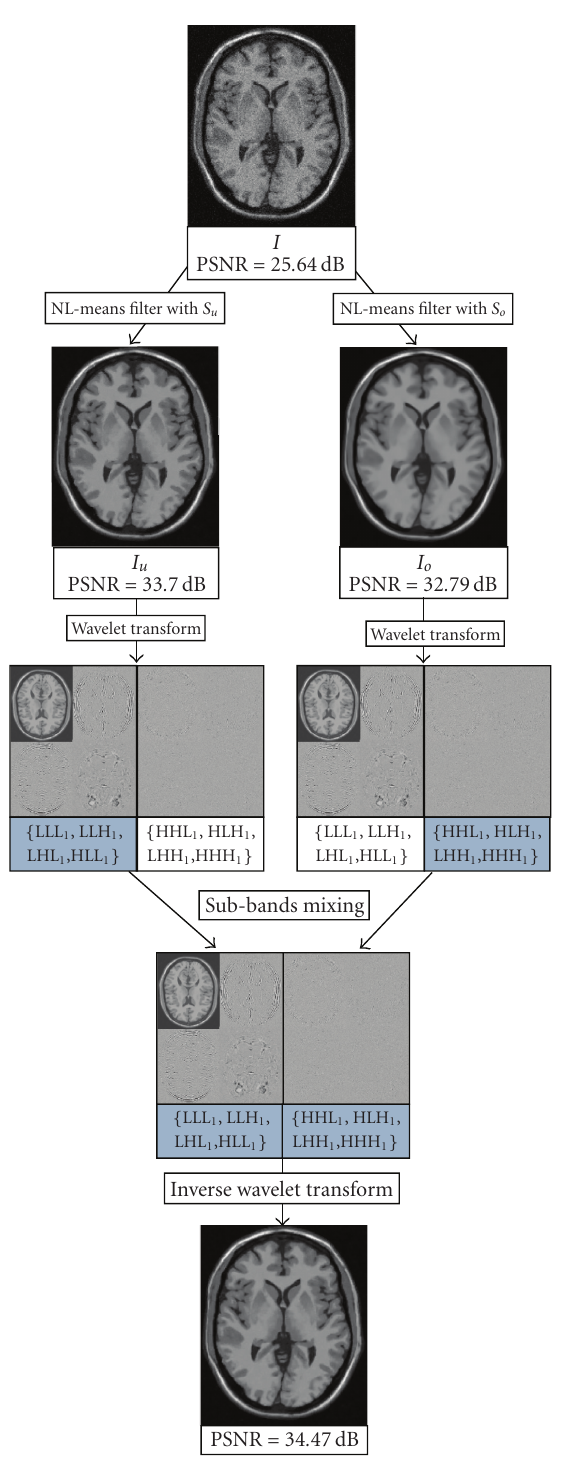
Figure 3: Workflow. First, the noisy image I is denoised with two sets of filtering parameters S u and S o . Then, I u and I o are decom- posed into low- and high-frequency subbands by 3D DWT. The four lowest frequency subbands of I u (i.e., LLL 1 , LLH 1 , LHL 1 , and HLL 1 ) are mixed with the four highest-frequency subbands of I o (i.e., LHH 1 , HLH 1 , HHL 1 , and HHH 1 ). Finally, the result image is obtained by inverse 3D DWT of the selected subbands.